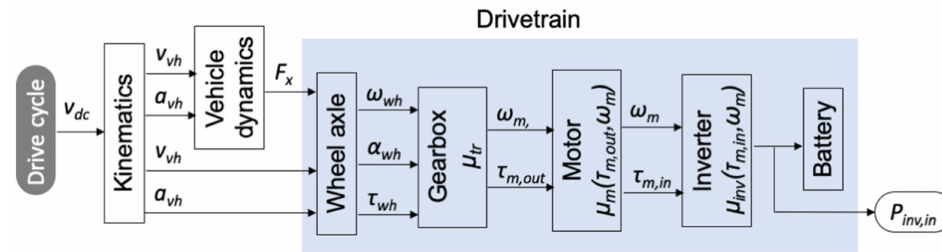
Figure 2. Signal flow in the vehicle